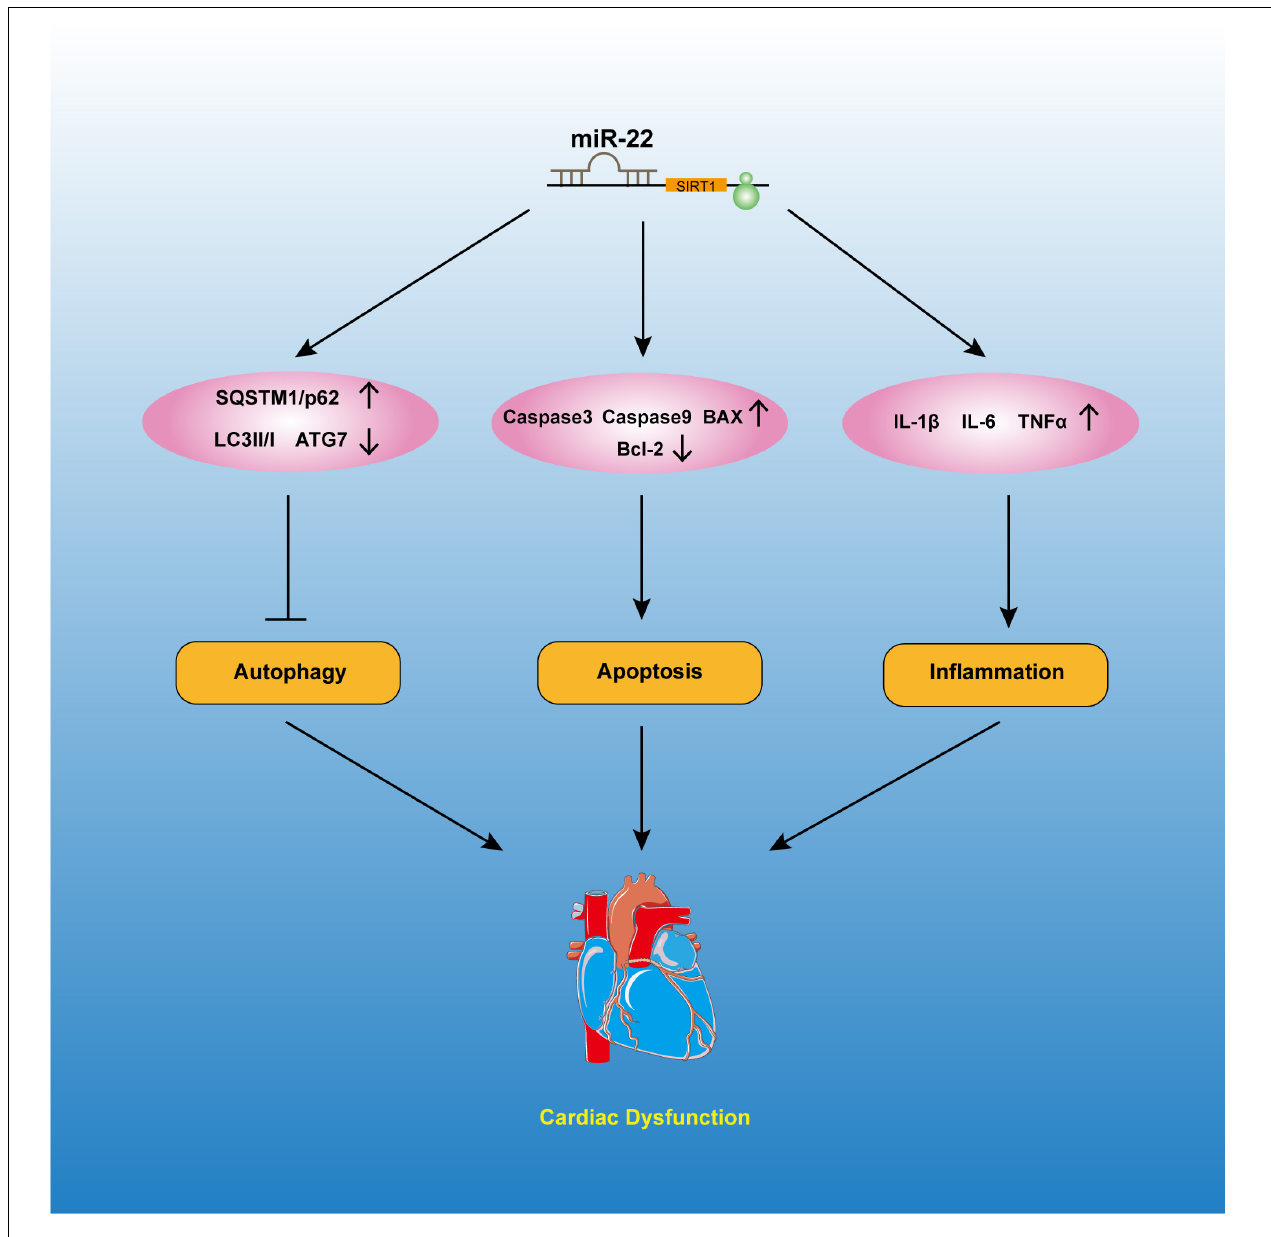
FIGURE 8 | The possible mechanisms involved in the effects of miR-22 in septic